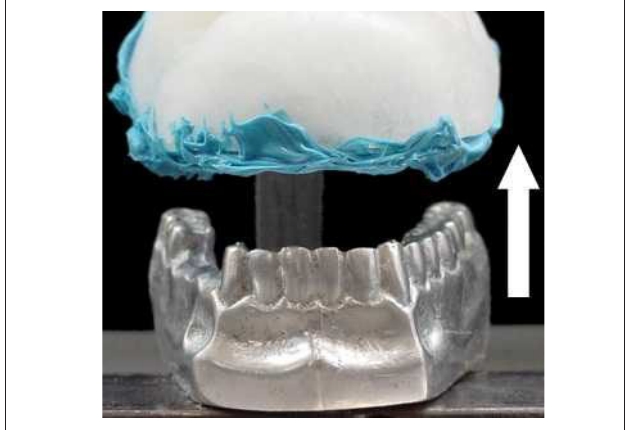
Fig. 2. Mold removal with single movement. After setting of the impression material, the tray was attached to the pneumatic equipment and the device actuated. Then, the tray was detached from the stainless steel model by upright movement.